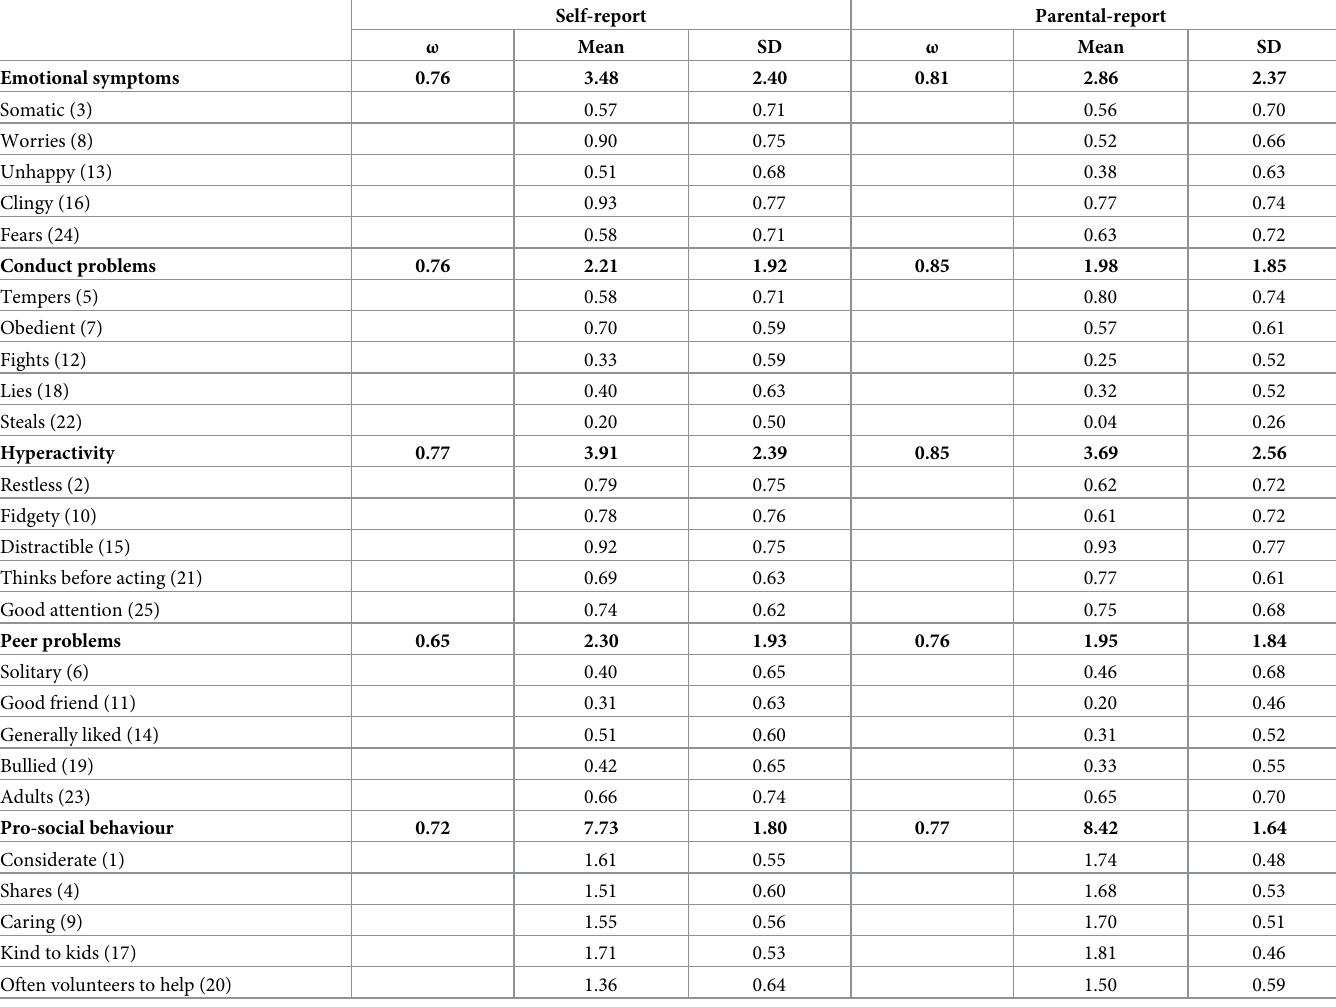
Table 3. Descriptive and standardized factor loadings for SDQ